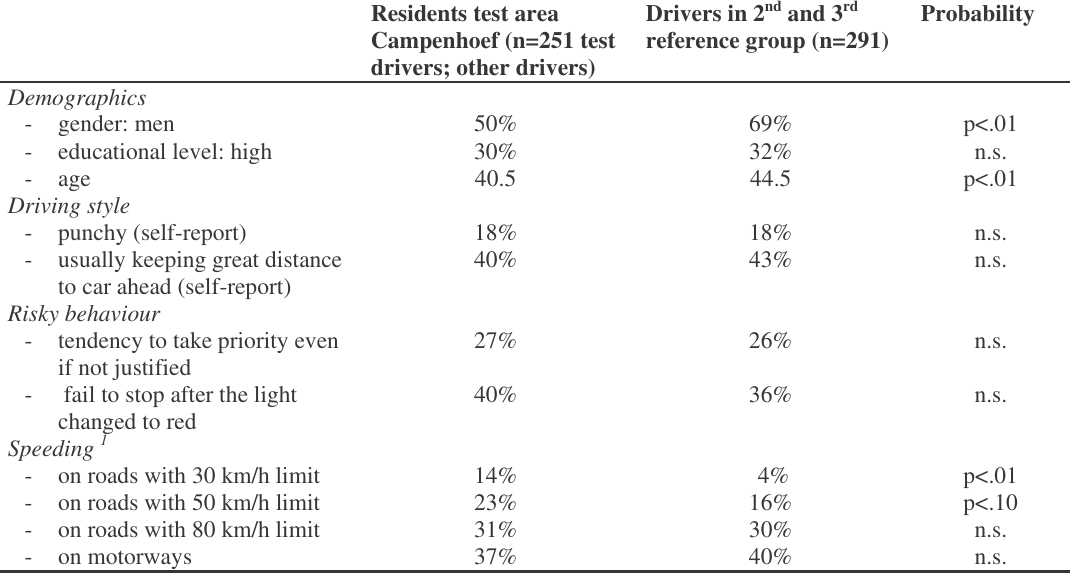
Table 3. Characteristics of test area drivers and drivers from outside the test